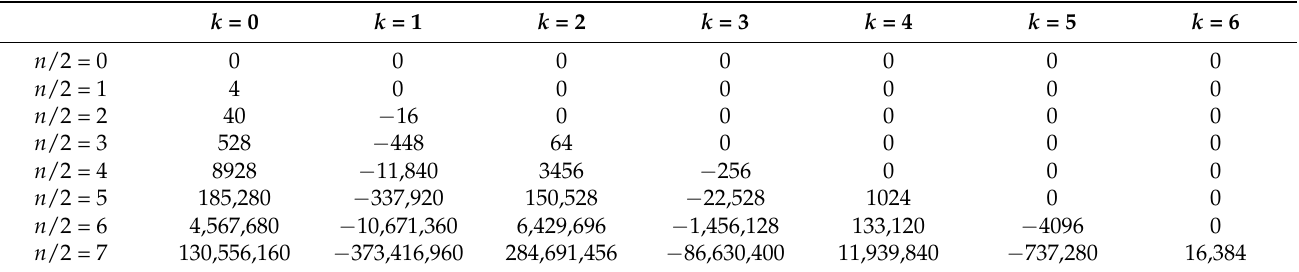
Table A1. The coefficients q n /2, k ( N ≤